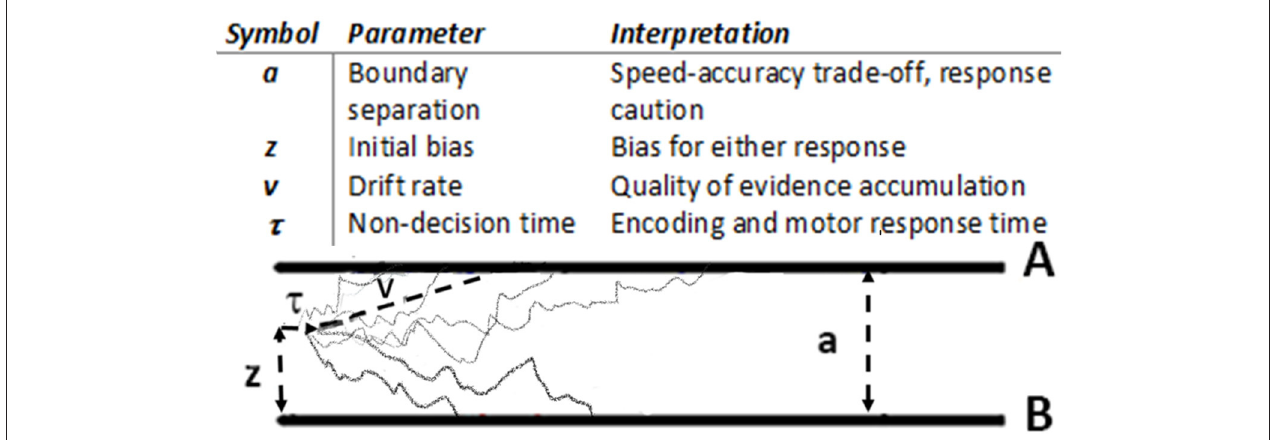
FIGURE 1 | Drift diffusion model (6): main parameters and graphical representation. During stimulus presentation, evidence is accumulated with an average rate v until reaching the Boundary A or B.